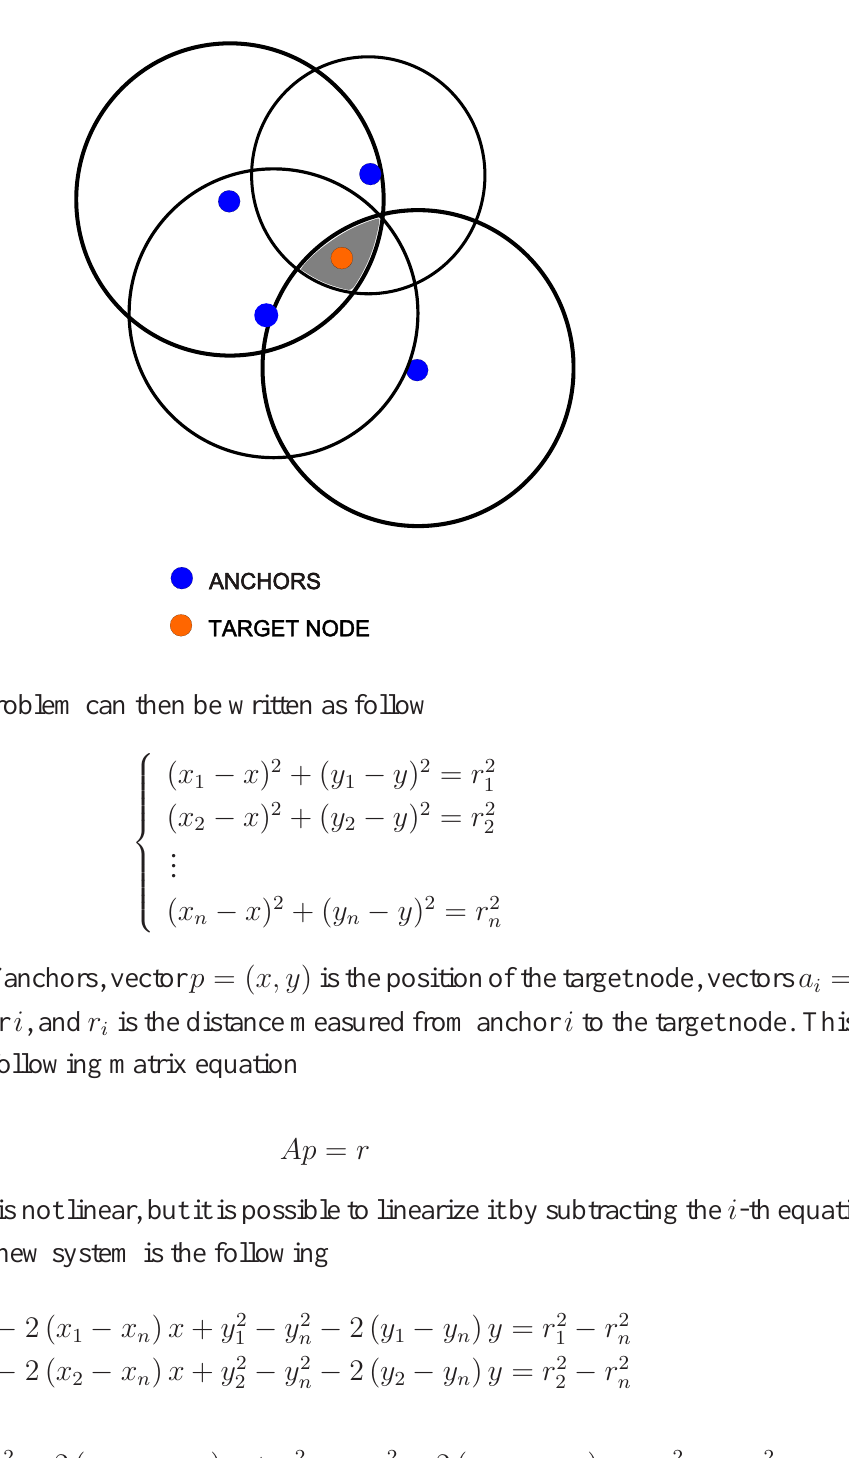
Figure 1. Example of a multilateration problem. The grey area is obtained as the intersection of the three circles centered at the anchors and is where the target node is expected to be